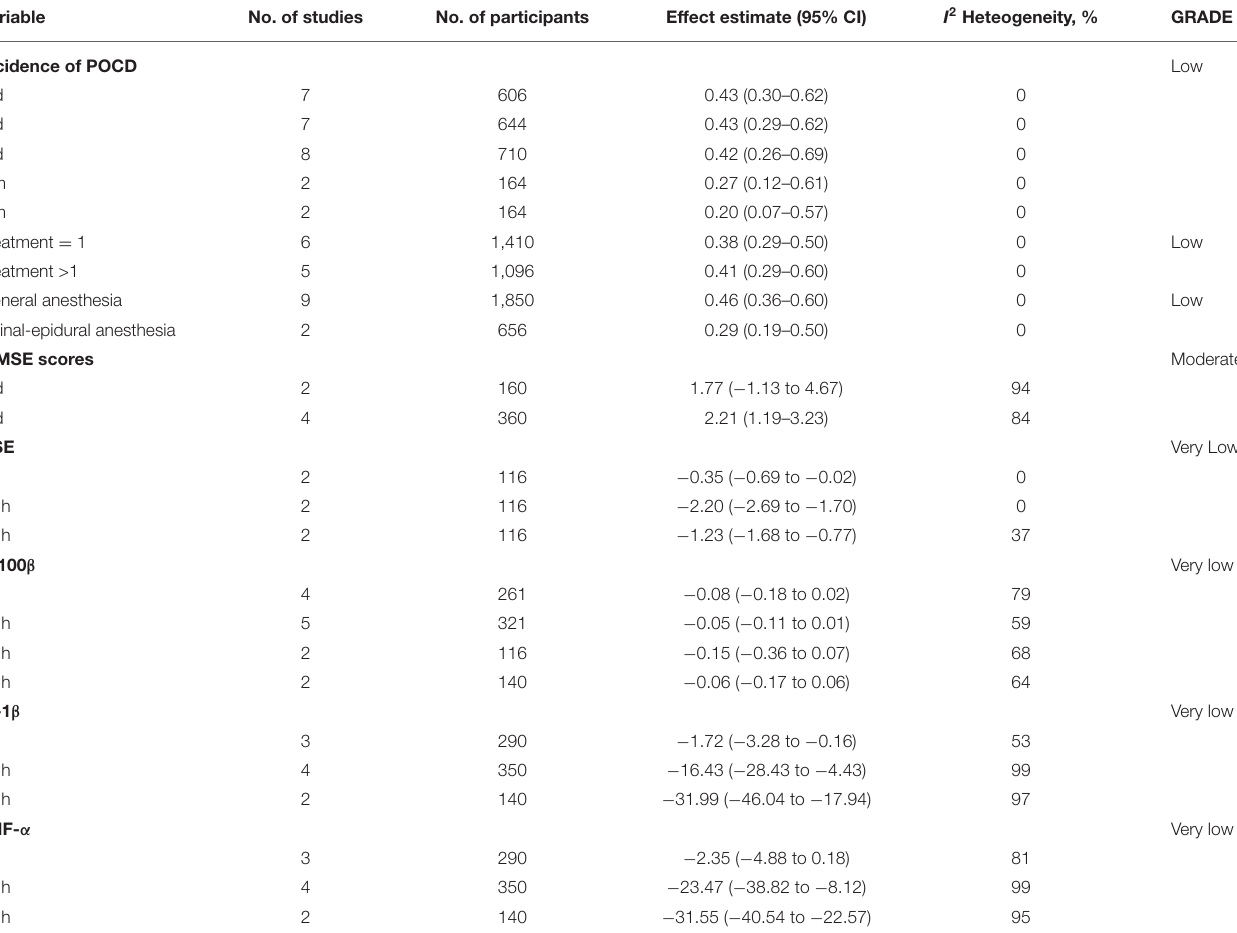
TABLE 2 | Main findings of the meta-analysis of electroacupuncture for the prevention of POCD after hip and knee arthroplasty. Variable No. of studies No. of